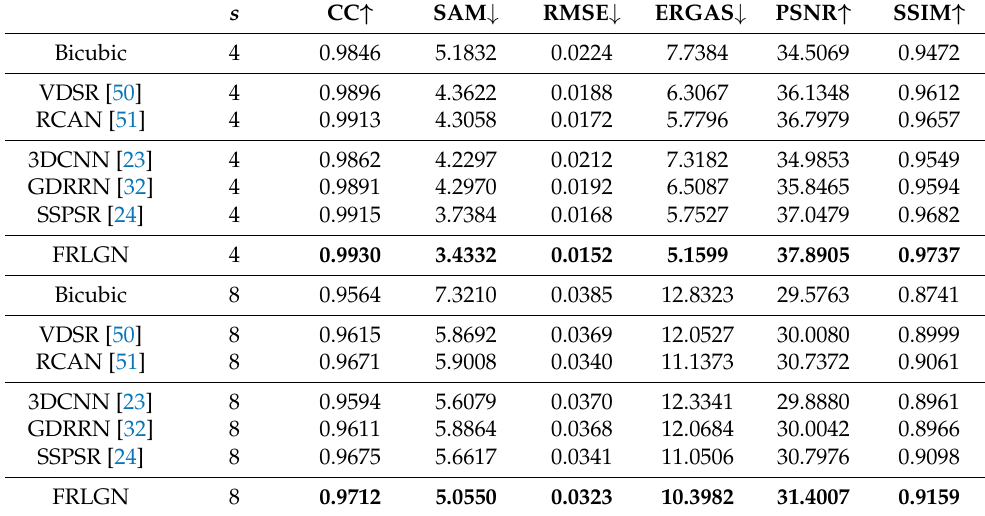
Table 5. Quantitative analysis of seven different comparison methods on CAVE test dataset involving six